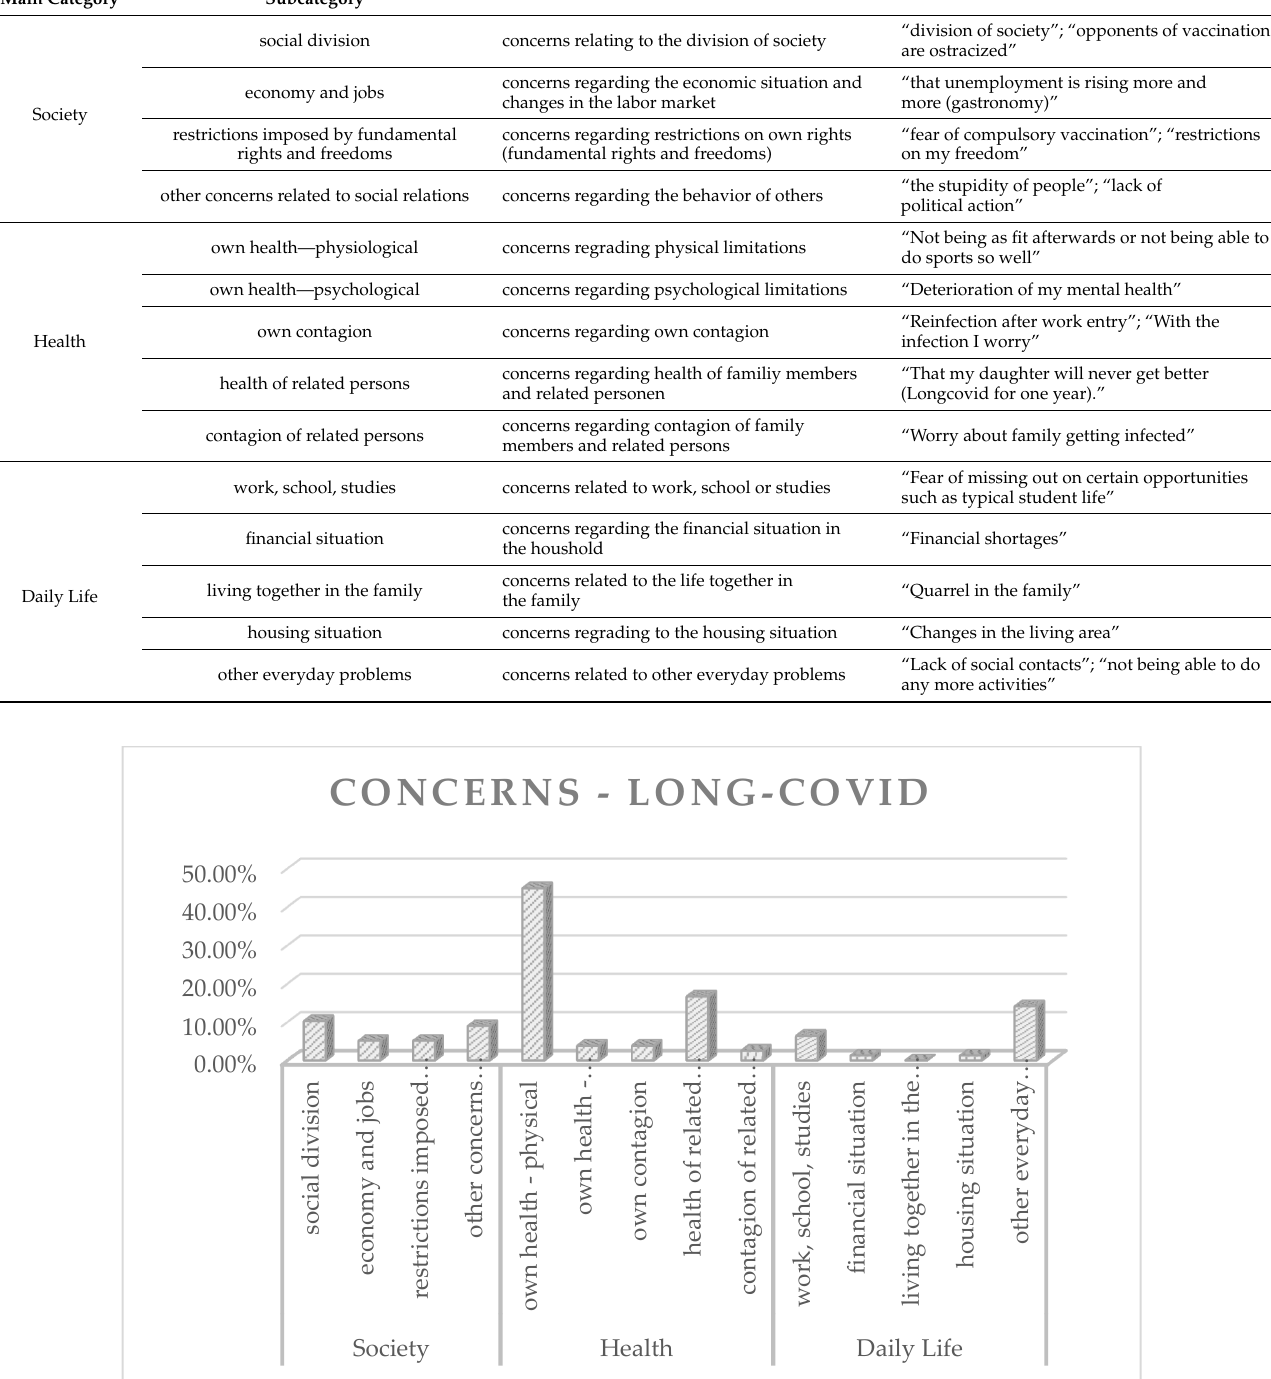
Figure 4. Percentages of pandemic-related concerns within the group “No infection” . The results of the frequency analysis show that animal caregivers who were suffering from a Long-Covid affliction by the time of the survey mostly stated concerns that could be assigned to the category “own health—physical” (44.87%). Regarding animal caregivers without an infection by the time of the survey, the results of the frequency analysis demonstrate that concerns are most frequently assigned to the subcategories “social division” (23.91%), “restrictions imposed by fundamental rights and freedoms” (19.57%), and “health of related persons” (17.93%). 3.2.2. Personal Opinion of the Animal’s Role during the Pandemic and Regarding Coping with Long-Covid To investigate the subjective opinion regarding the animal’s role during the pandemic in general as well as in connection with coping with Long-Covid, the following